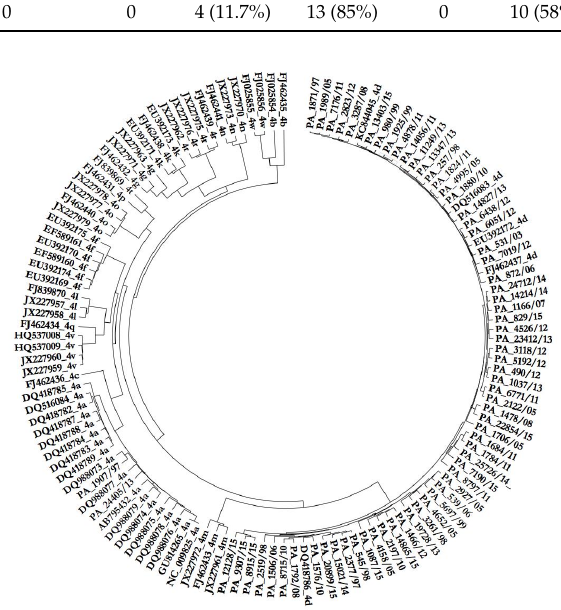
Figure 1. Phylogenetic tree of the NS3 region (450 bp) made with T93 + G + I (bootstrap 1000 replicates) containing 67 sequences from Direct Acting Antivirals (DAA) naïve patients (PA number / year) and